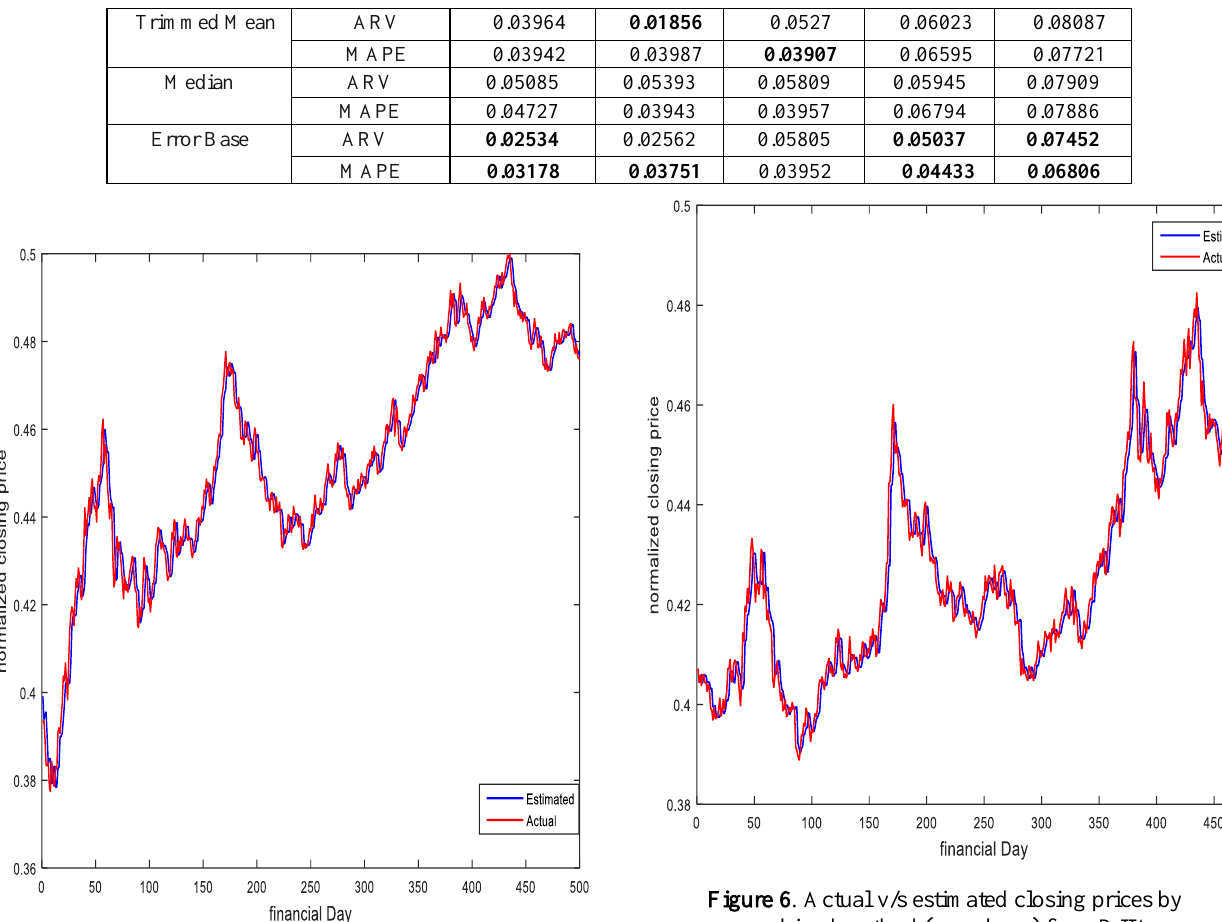
Figure 5 . Actual v/s estimated closing prices by combined method (trimmed mean) from NASDAQ